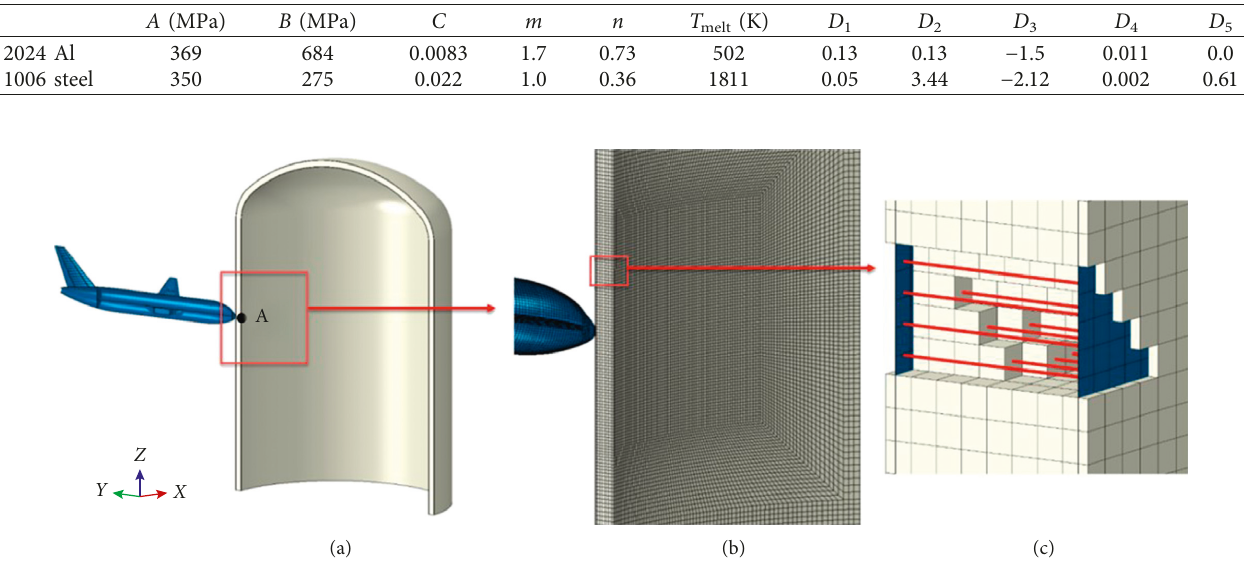
Figure 3: Illustration of the FE model of the containment building. Table 3: Element sizes in the mesh sensitivity study. Case